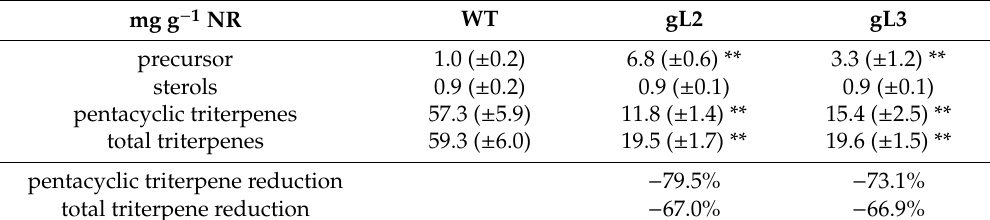
Table 2. Isoprenoid analysis of acetone extracts from NR isolated from TkOSC -RNAi and NIL roots of the T1 generation. Extracts in duplicate or triplicate were made from the material of three NIL-, two gL2-, and three gL3-plants, respectively; asterisks denote statistical significance compared to control (two-tailed t test, ** p < 0.01); precursor: triterpene (squalene and 2,3-oxidosqualene) and sterol precursor (cycloartenol and 24-methylene cycloartanol); sterols: campesterol, stigmasterol and sitosterol; pentacyclic triterpenes: taraxasterol, α - and ß-amyrin, lup-19(21)-en-3-ol, lupeol, taraxerol and four unknown triterpenes (free triterpenes (alcohols) as well as acetate derivatives); total triterpenes: precursor, sterols and pentacyclic triterpenes; single triterpene levels are shown in Table S4. mg g − 1 NR WT gL2 gL3 precursor 1.0 ( ± 0.2) 6.8 ( ± 0.6) ** 3.3 ( ± 1.2) ** sterols 0.9 ( ± 0.2) 0.9 ( ± 0.1) 0.9 ( ± 0.1) pentacyclic triterpenes 57.3 ( ± 5.9) 11.8 ( ± 1.4) ** 15.4 ( ± 2.5) ** total triterpenes 59.3 ( ± 6.0) 19.5 ( ± 1.7) ** 19.6 ( ± 1.5) ** pentacyclic triterpene reduction − 79.5% − 73.1% total triterpene reduction − 67.0% −